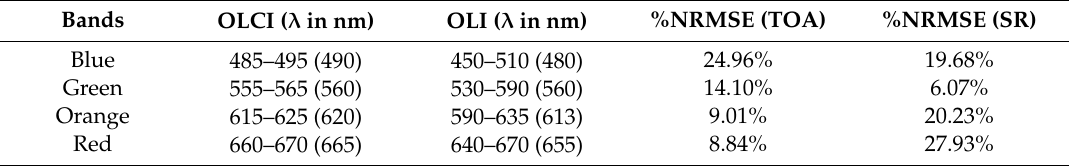
Figure 3. Regression between the OLCI- and OLI-derived TOA reflectance for the ( a ) blue, ( b ) green, ( c ) orange, and ( d ) red bands. Regression between the OLCI- and OLI-derived SR for the ( e ) blue, ( f ) green, ( g ) orange, and ( h ) red bands. Blue lines are trend lines and black lines are a 1:1 line for each band. Table 1. Bandwidth of various bands (band centers are in parentheses) corresponding to the OLCI and OLI and respective percentage normalized root mean square errors (%NRMSE) for TOA and surface reflectance comparison between the two